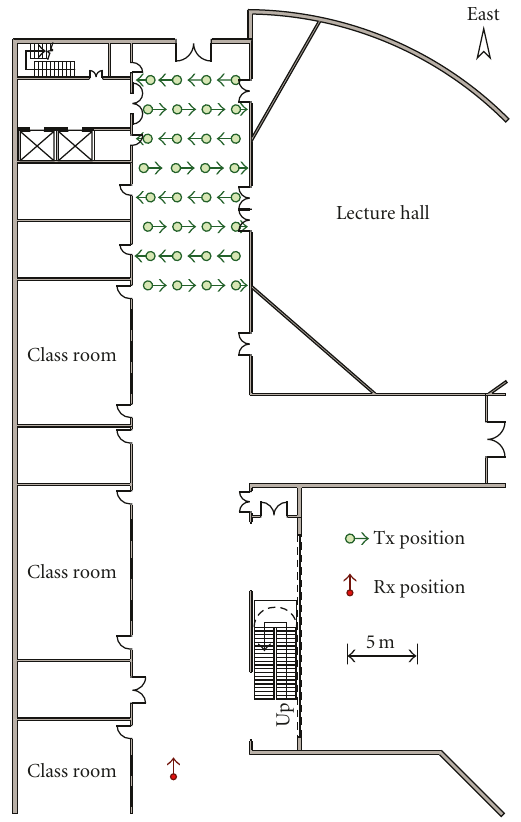
Figure 5: Layout of the indoor measurements in the